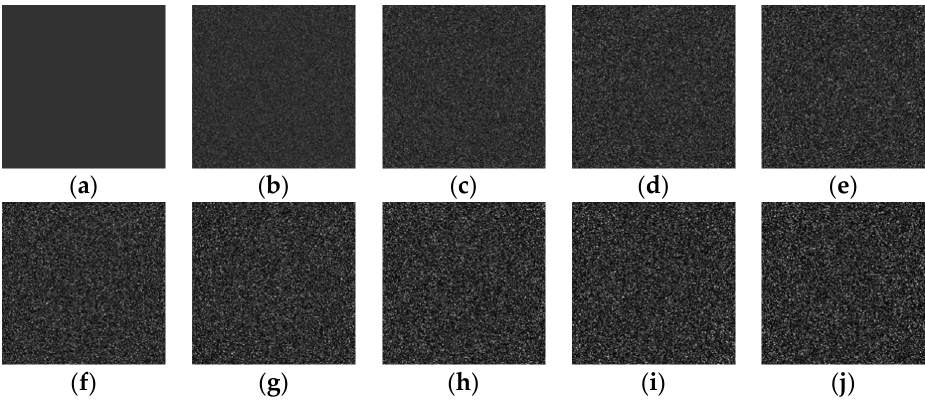
Figure 3. Gamma noise with different intensities is added to the gray image with a grayscale of 50: ( a ) original image, ( b ) var = 0.1, ( c ) var = 0.2, ( d ) var = 0.3, ( e ) var = 0.4, ( f ) var = 0.5, ( g ) var = 0.6, ( h ) var = 0.7, ( i ) var = 0.8, and ( j ) var = 0.9. To further explore the influence of multiplicative gamma noise on the overall average gray value, we added random gamma noise with a noise variance of 0.1–0.9 to gray im- ages, calculated the average gray value, and repeated the 20 experiments. From Figure 4, we can see that the average gray value decreased with the increase in noise intensity, and the degree of decline gradually increased.